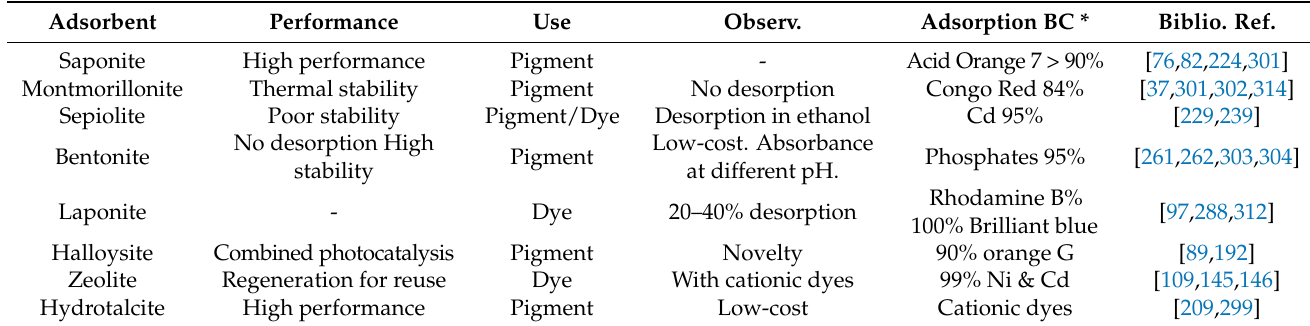
Table 2. Comparison of different clays.